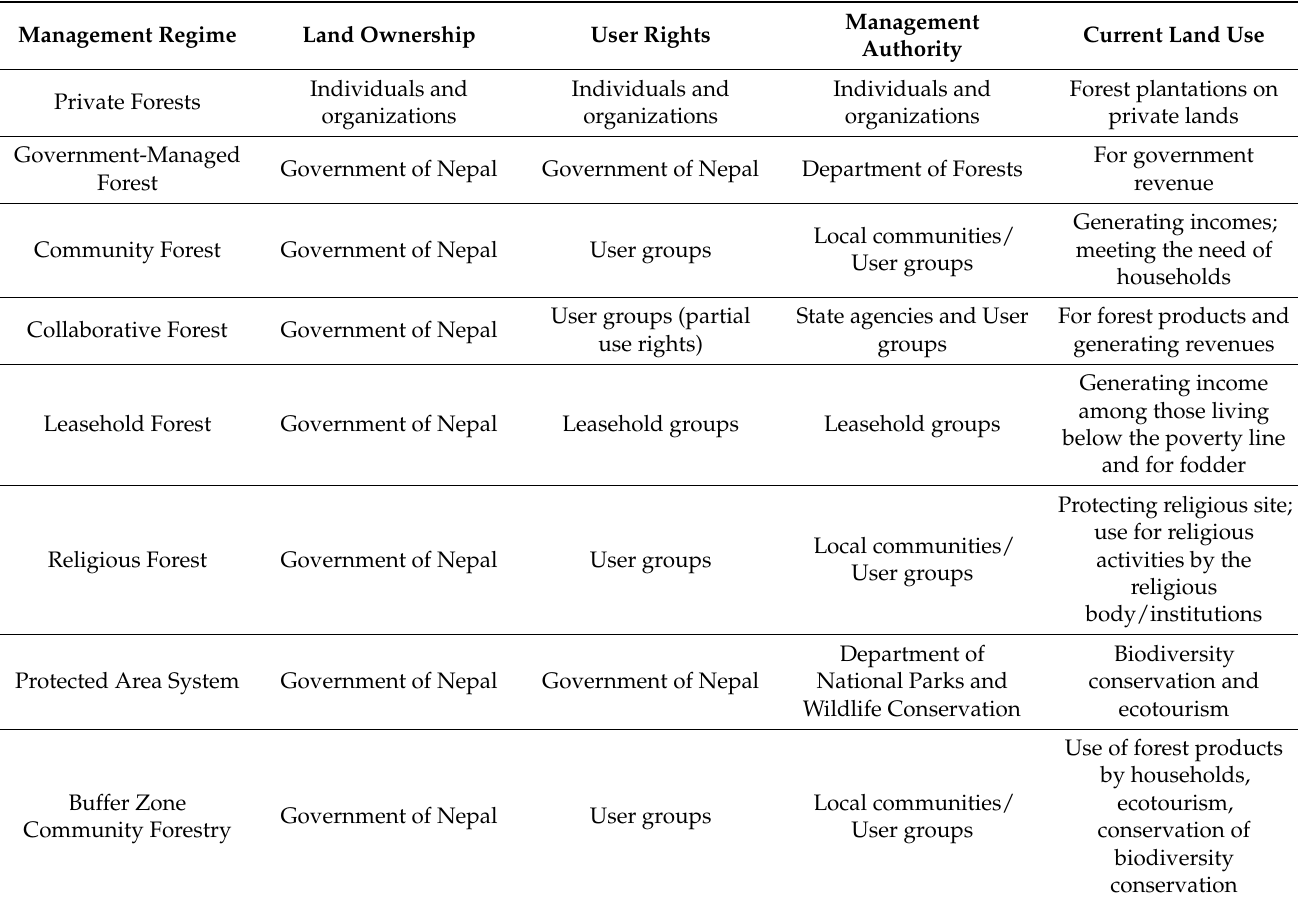
Table 3. Major forest management regimes in